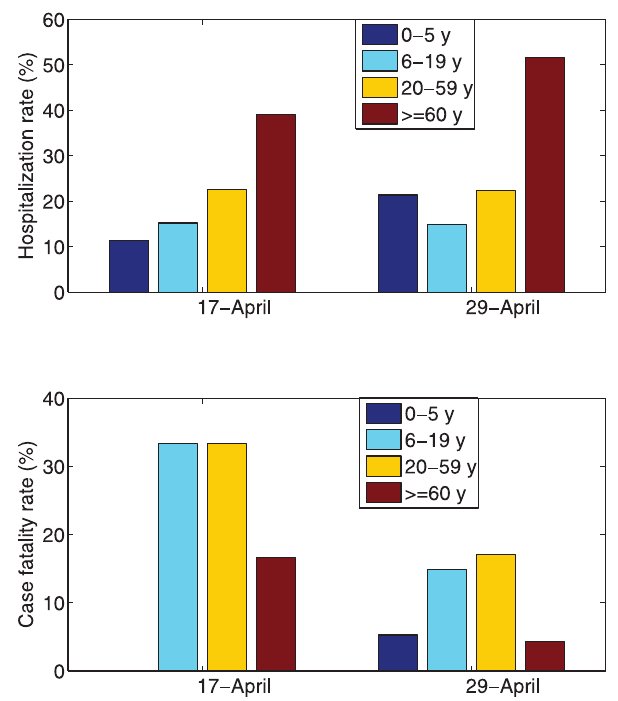
Figure 2. Age-specific hospitalization and case fatality rates given hospitalization estimated from cumulative morbidity and mortality data from the National Surveillance System stratified by four broad age groups at two time points into the S-OIV outbreak in Mexico. The Ministry of Health issued an epidemiologic alert on April 16 and 17 and selective reporting of severe pneumonia cases ceased on April 29. Case fatality rate is estimated as the proportion of deaths among hospitalized pneumonia cases.